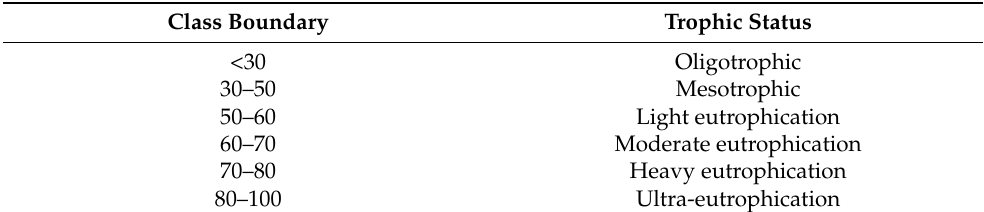
Table 2. Class boundaries and trophic status of the lake according to the CDI.